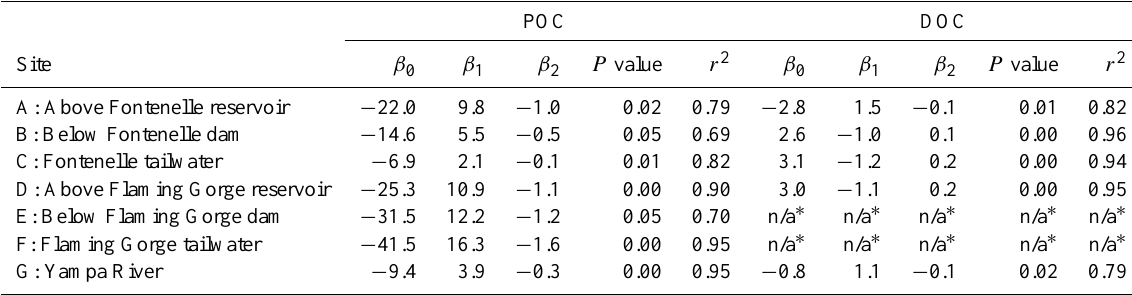
Table 1. A regression model to estimate daily organic carbon concentrations [OC] from mean discharge ( Q ), ln[OC] = β 0 + β 1 ln[ Q ] + β 2 ln[ Q ] 2 , was fit for each sampling site in order to estimate annual [OC] loads. POC refers to particulate organic carbon and DOC is dissolved organic carbon. β 0 , β 1 , and β 2 are the model coefficients for each sampling site. P value and r 2 are selected corresponding model statistics at each site. Letters A–G preceding the site names correspond to sites A–G in Fig. 1.